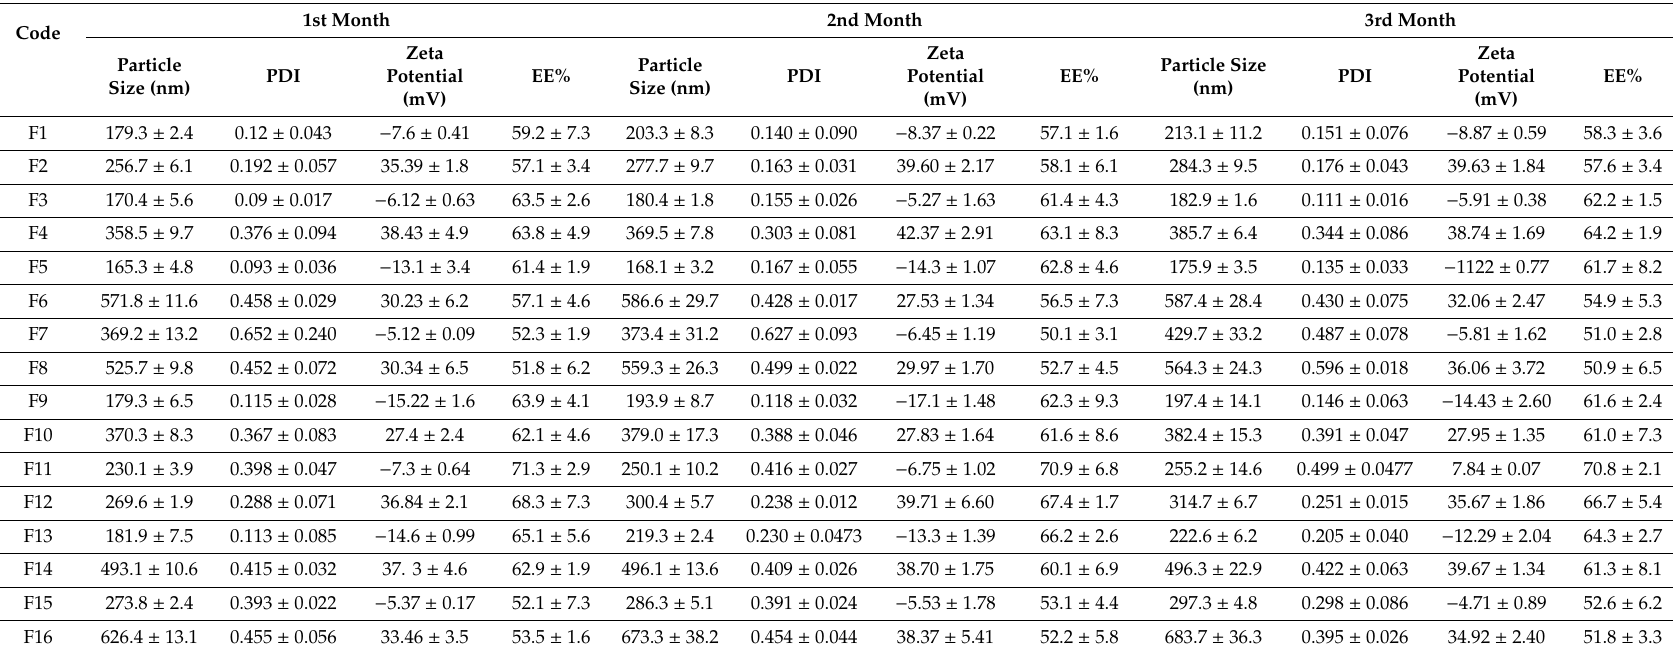
Table 3. Particle size, PDI, zeta potential, and EE% of PP loaded nanoparticles within 3 months ( n = 3, ±